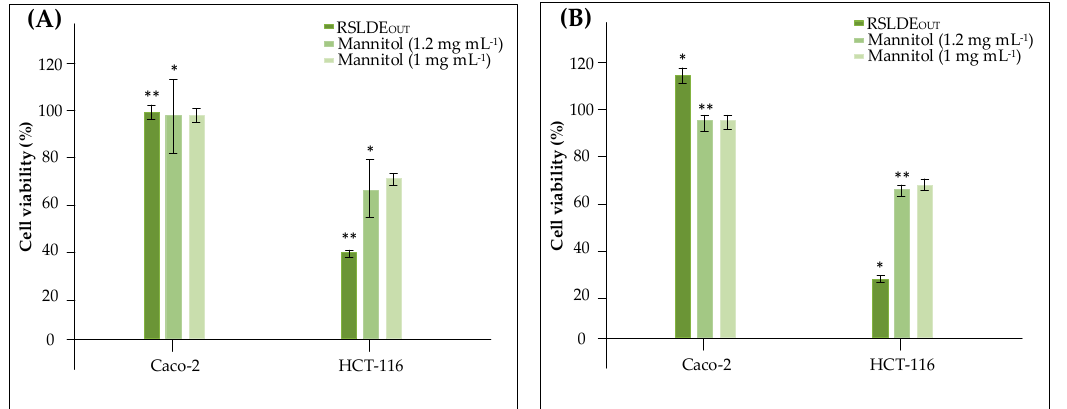
Figure 7. Comparison of proliferative activities on Caco ‐ 2 (non ‐ proliferative) and HCT ‐ 116 (proliferative) cell lines of RSLDE OUT (containing 1.1 mg mL − 1 of mannitol) and the mannitol concentrations at 1 and 1.2 mg mL − 1 after 24 ( A ) and 48 h ( B ) exposure (* p < 0.05, ** p < 0.01).